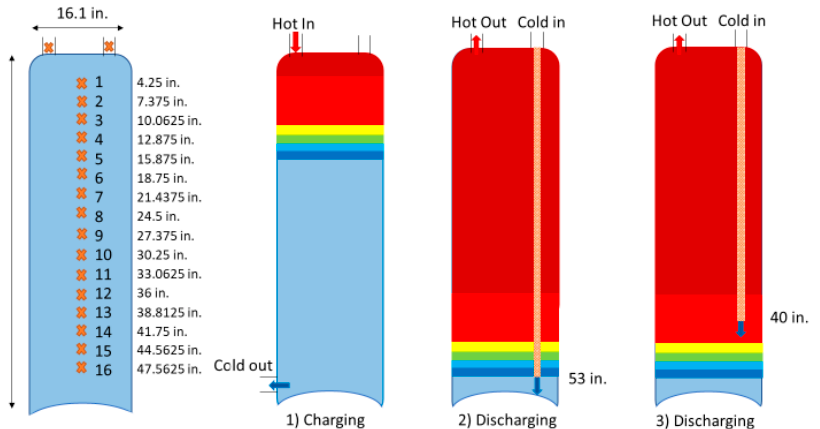
Figure 1. Experimental setup with locations of measured temperature marked by an “X” within the tank (left). Modeled conditions: (1) Charing cycle flow path with hot water coming from the top. (2) Cold water entering below the thermocline via the long vertical tube. (3) A 40 in. VTI delivering water above the thermocline.